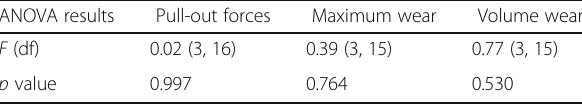
Table 3 Stability of conditions across four CS rounds ANOVA results Pull-out forces